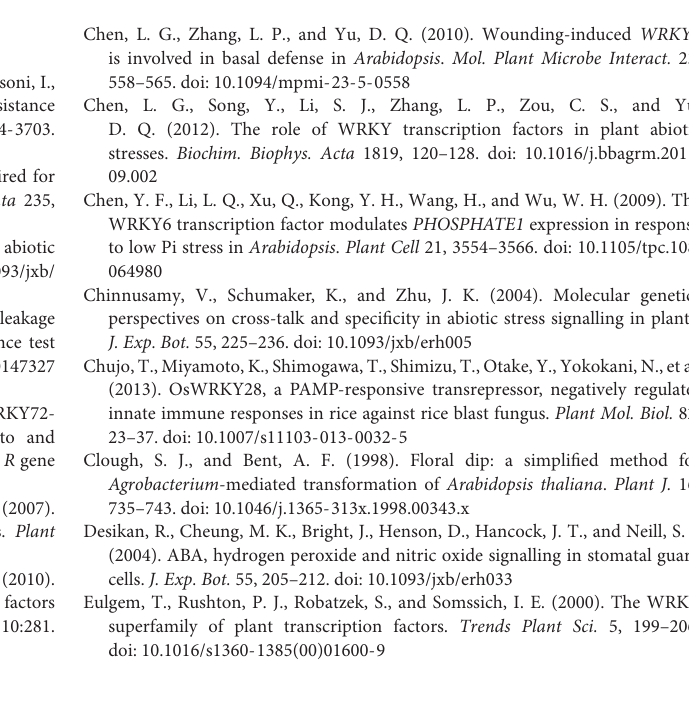
FIGURE S2 | VlWRKY3 expression and abiotic and biotic-responsiveness in transgenic Arabidopsis thaliana . (A) The expression level of VlWRKY3 in 4-week-old seedling leaves from untreated WT and three independent transgenic lines (L1, L2, and L3) over-expressing the VlWRKY3 . Asterisks indicate statistical significance ( ∗∗ P < 0.01, Student’s t -test) in comparison with WT. (B) The expression level of VlWRKY3 in WT and transgenic lines that were subjected to